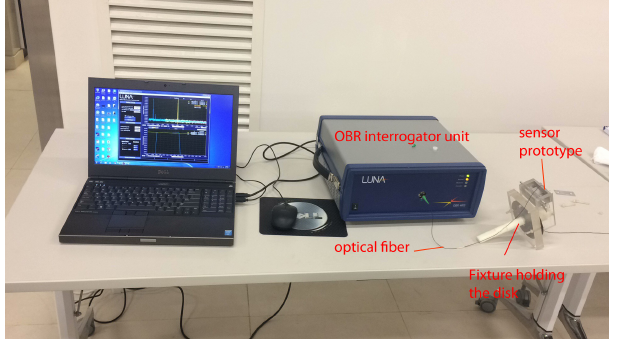
Figure 8. Experimental setup.